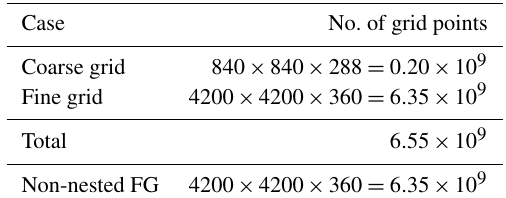
Table 4. Number of grid points in nested and non-nested FG do-